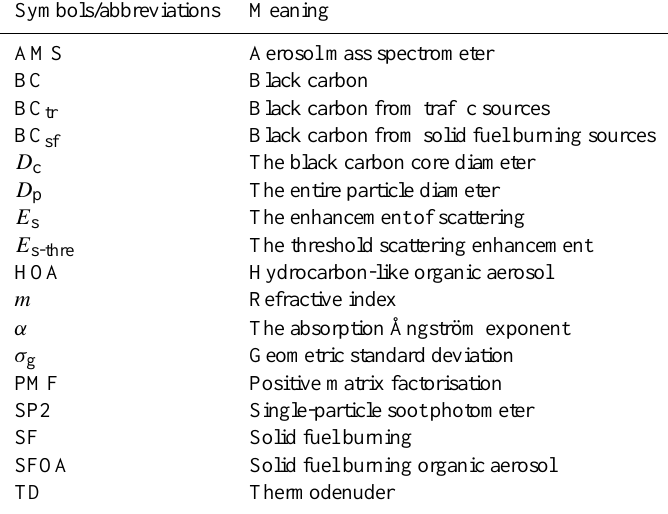
Table A1. Symbols and